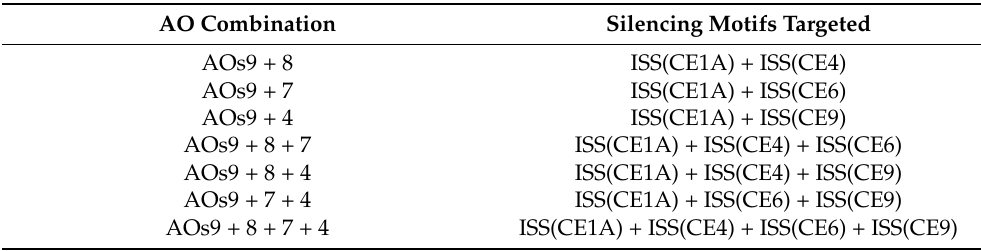
Table 1. List of AO combinations targeting the four splice silencing motifs located in introns adjacent to hnRNPA1 exon 7b.